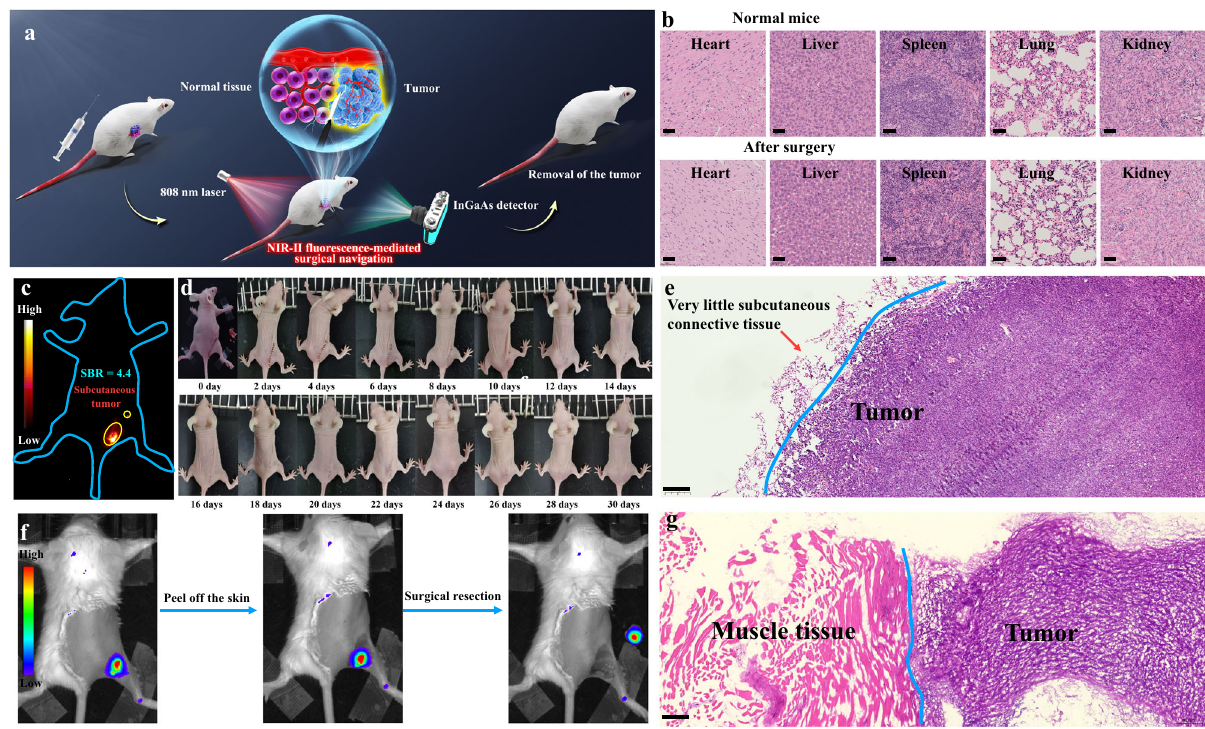
Fig. 6 | Surgical navigation for subcutaneous tumors and recovery assess- ments. a Schematic diagram of NIR-II fl uorescence-mediated surgical navigation. b Histology studies of normal mice and tumor-removal mice for different organs, scale bar: 50 μ m. The histological studies indicated that the surgical resection did not damage any organs of the mice. The experiment was repeated three times independently, with similar results. c NIR-II imaging in vivo before surgical navi- gationwith HPQ-Zzh-B , λ ex =808nm,collectionchannel:1000 – 1700nm. d Photos of mice at different time (every 2 days) after surgery. The experimental mice gra- dually recovered health. e Histology studies of tumor resected after NIR-II fl uor-